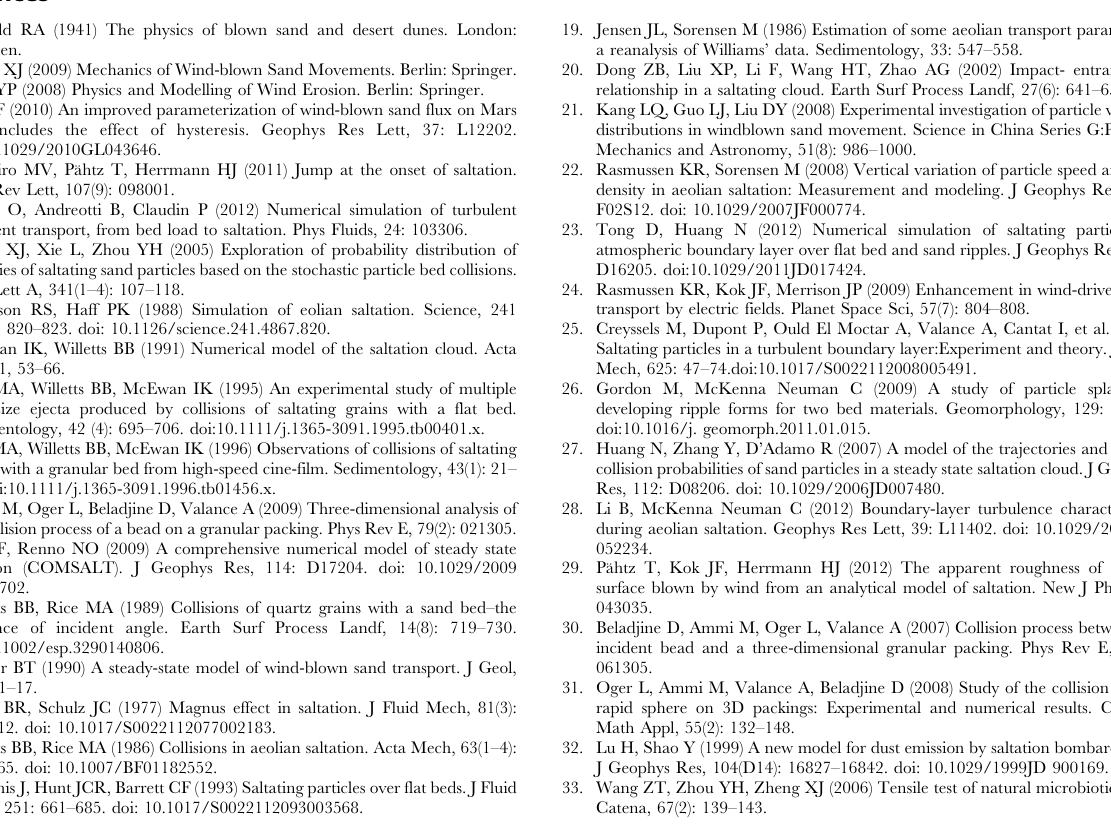
Figure B says the vertical profiles of time-averaged stream-wise velocity. Table S1 tells the fitting parameters of the distributions of incident